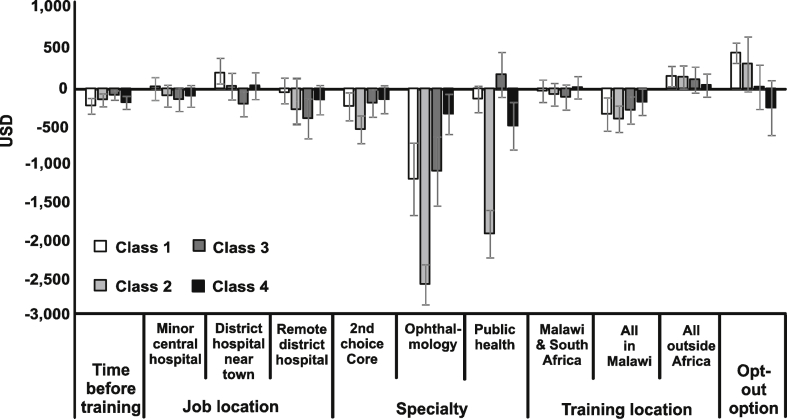
Willingness to pay. Positive values indicate the amount of future income participants would give up in order to gain a unit increase or level change in an attribute, whereas negative values indicate the amount that a participant would want as compensation. Reference levels = Major central hospital, 1st choice core specialty and training all in South Africa. 95% confidence intervals shown.